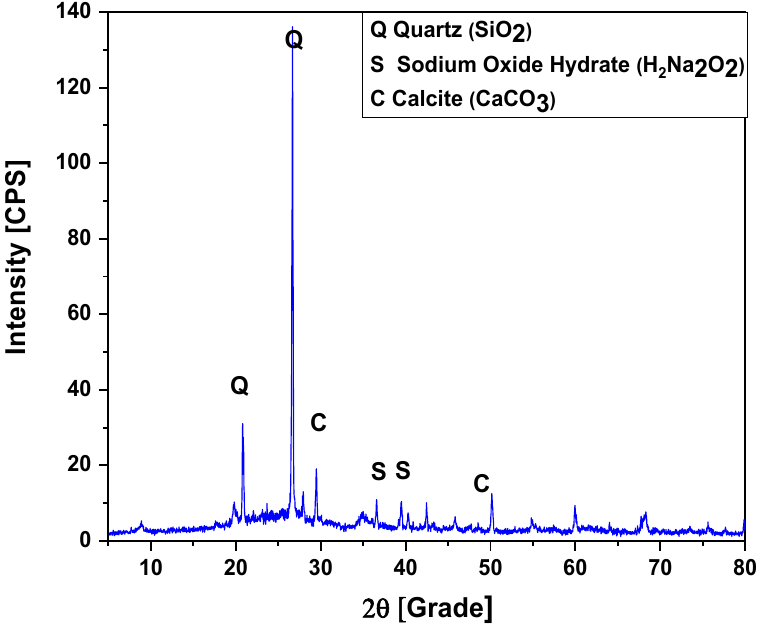
Figure 9. XRD of Si–Al Ash pellets after upgrading experiments.